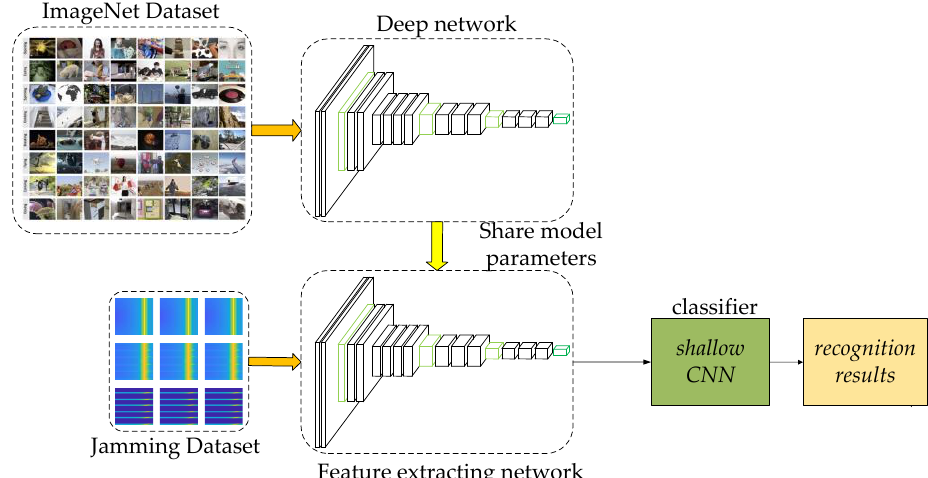
Figure 5. The structure of pre-training networks.